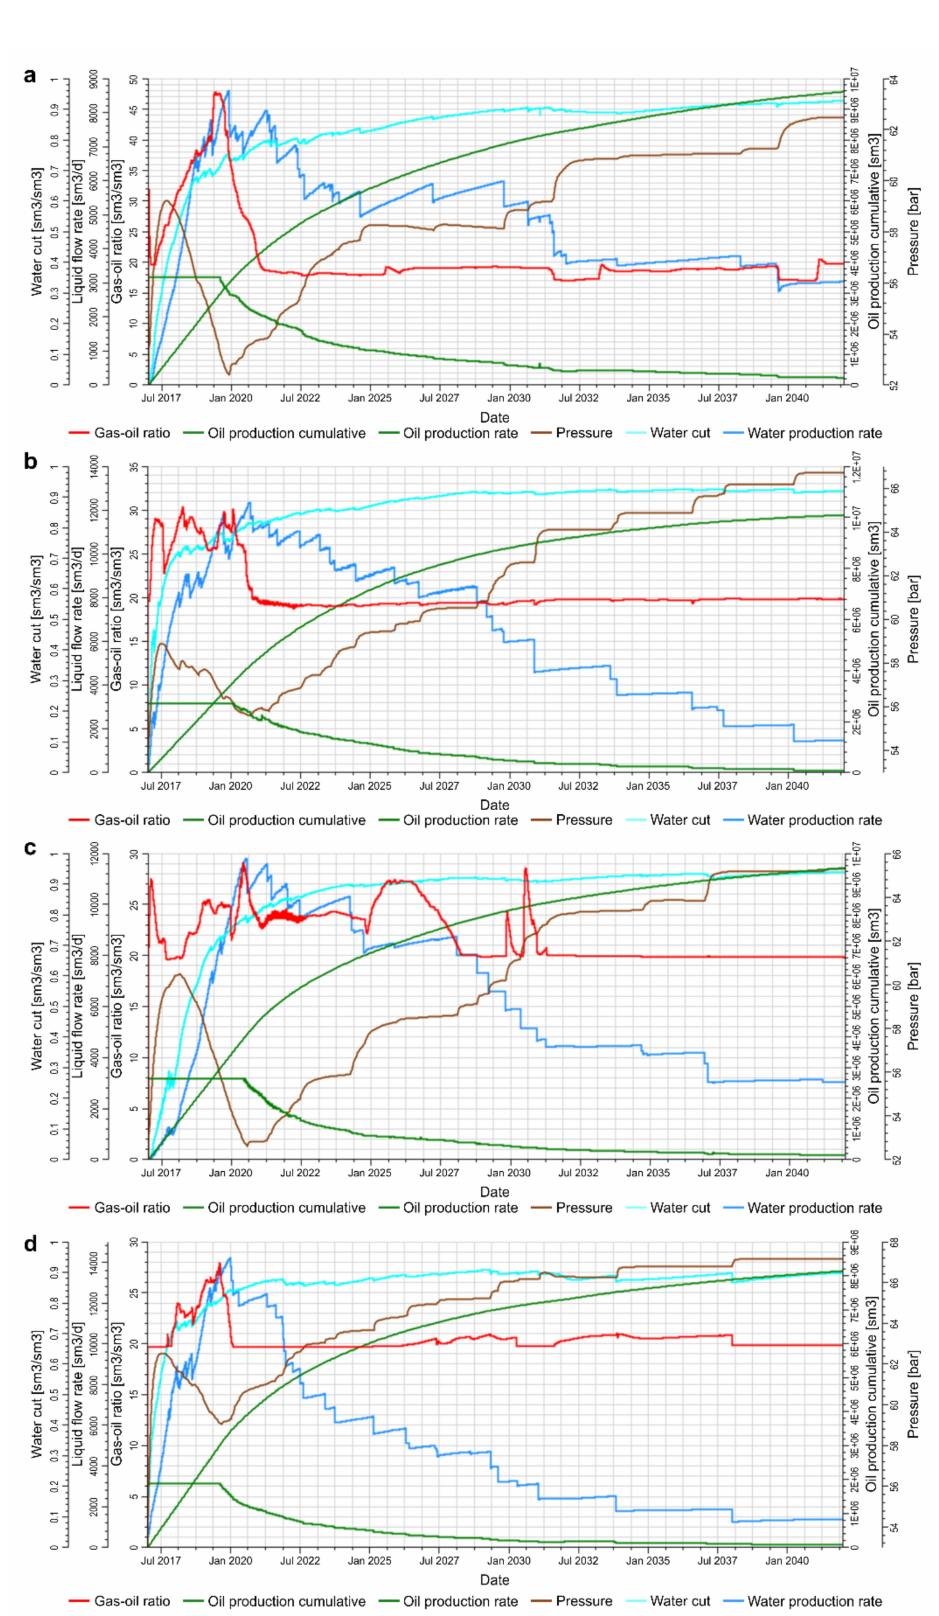
Figure 10. Trends in different properties for each well type. ( a ) Performance of vertical wells in the B27 reservoir, ( b ) production profiles of horizontal wells in the B27 reservoir, ( c ) performance of multilateral wells in the B27 reservoir, and ( d ) production profiles showing the performance of highly deviated wells in the B27 reservoir. The pressure considered is the reservoir